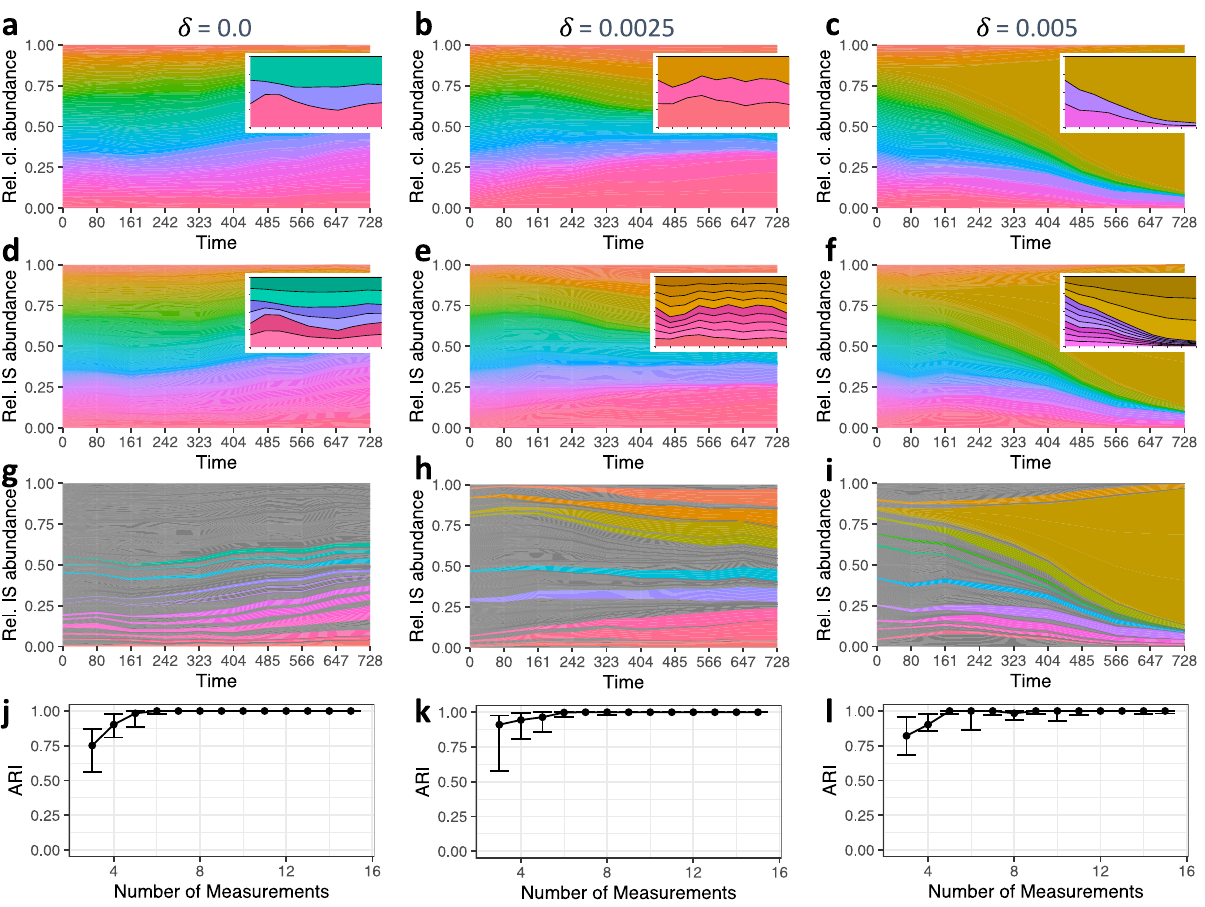
Fig. 3 Time series of clonal development and their reconstruction based on IS measurements. a , b , c Clonal time series (100 initial clones, 100 cells each) for increasing values of the standard deviation δ of the differentiation rate with an increasing tendency for clonal conversion (left: “ equal clones ” vs. right: “ pronounced clonal advantage ” ). Insets focus on the three largest clones only. d , e , f Corresponding time series for IS, which are superimposed in each clone. The insets represent the IS substructure of the three largest clones. g , h , i Remaining time series after the fi ltering step, which limits the analysis to the 50 largest IS being present at the fi nal time point. j , k , l Quality of the clonal reconstruction process as a function of the number of available, equally spaced time points for IS measurements. Reconstruction quality is measured by calculating the adjusted Rand index (ARI) between the known ground truth and the reconstructed clustering (ARI → 1 indicating perfect reconstruction; quantitative analysis is based on 20 independent simulations each; points indicate the median; whiskers correspond to the fi rst and third